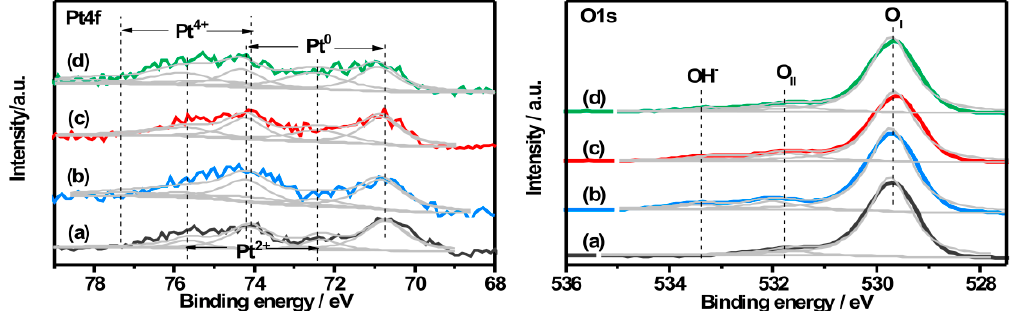
Figure 4. Temperature programmed oxidation ( TPO) pattern of the pristine Pt/TiO 2 catalyst and temperature programmed oxidation (TPR) pattern of the unreduced Pt/TiO 2 catalyst.